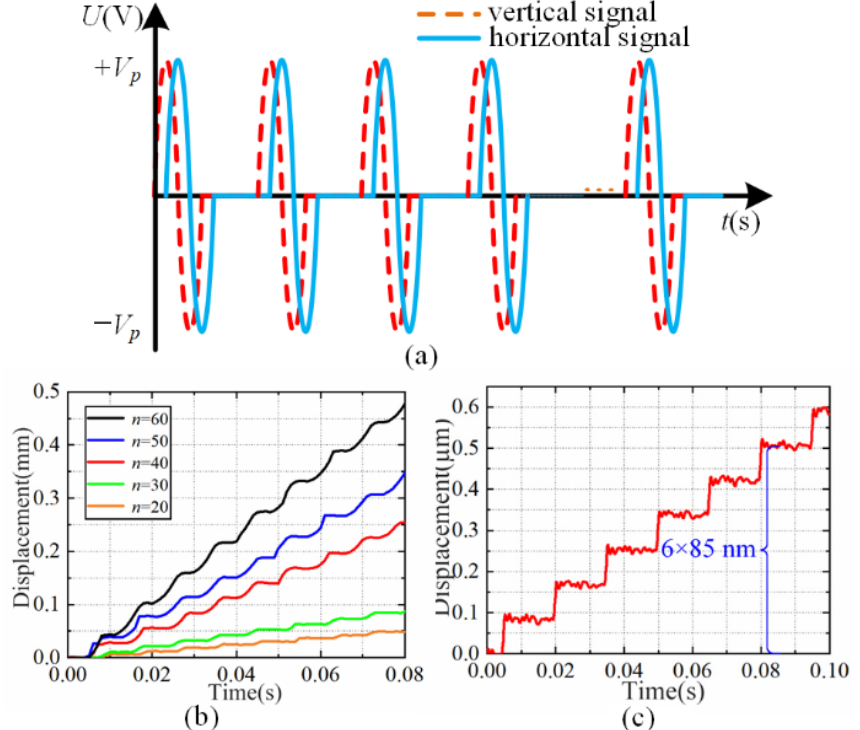
Figure 10. Excitation signal and output displacement characteristics. ( a ) Sinusoidal alternating current pulse signal. ( b ) Output displacement under the pulse signal. ( c ) Output displacement under one signal. Table 5. Comparison between the proposed ultrasonic motor and some existing works. The Parameters This Work